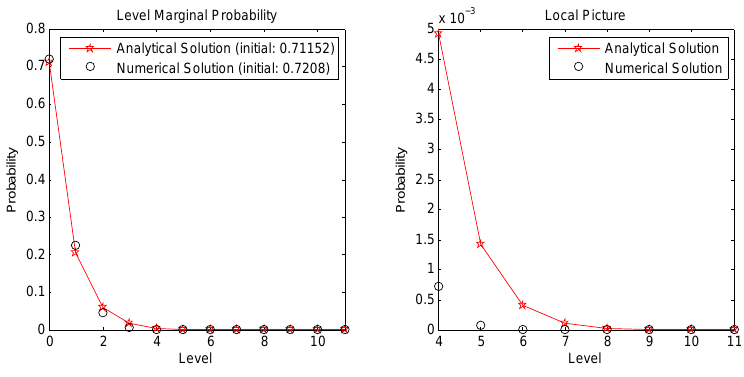
Figure 6. Level marginal invariant probability distribution L Π k .